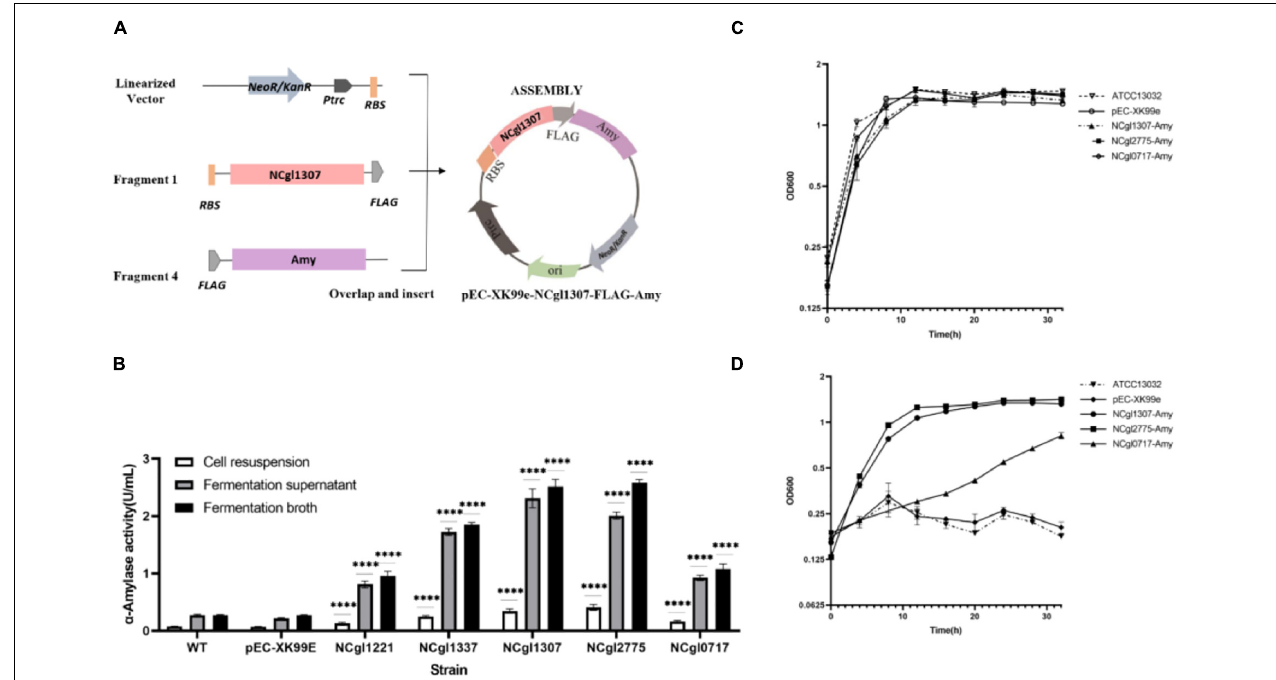
FIGURE 3 | Display of α -amylase on the cell surface using NCgl1307, NCgl2775, or NCgl0717 as anchoring motifs. (A) Construction and identification of a recombinant Corynebacterium glutamicum surface display system with α -amylase as passenger protein. Take the construction of Ncgl1307-amylase as an example. Using the amylase gene as a template and Amy F and Amy R as primers, the target protein amylase gene fragment 4 was amplified. Then, Seamless Assembly Cloning Kit was used to assemble fragment 1, fragment 4, and linearized vector ( Figure 1A ). (B) α -Amylase activity assay with WT, NC (cells harboring pEC-XK99e), cells harboring NCgl1307-Amy, NCgl2775-Amy, and NCgl0717-Amy, respectively. The data represent the mean value and standard deviation of biological triplicates. Statistical significance, ∗∗∗∗ P < 0.0001. (C) Growth curve of C. glutamicum with glucose as the sole carbon source, including WT, pEC-XK99e, NCgl1307-Amy, NCgl2775-Amy, and NCgl0717-Amy (representing cells harboring pEC-XK99e, NCgl1307-Amy, NCgl2775-Amy, or NCgl0717-Amy, respectively). (D) Growth curve of C. glutamicum with starch as the sole carbon source, including WT, pEC-XK99e, NCgl1307-Amy, NCgl2775-Amy, and NCgl0717-Amy (representing cells harboring pEC-XK99e, NCgl1307-Amy, NCgl2775-Amy, or NCgl0717-Amy, respectively). The data represent the mean value and standard deviation of biological